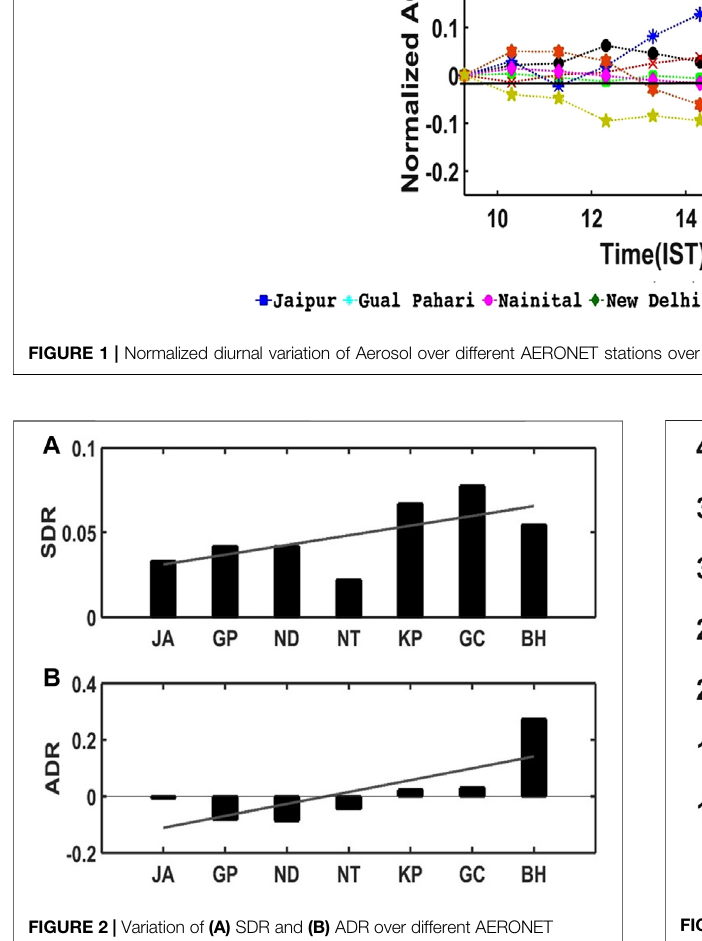
FIGURE 2 | Variation of (A) SDR and (B) ADR over different AERONET stations.